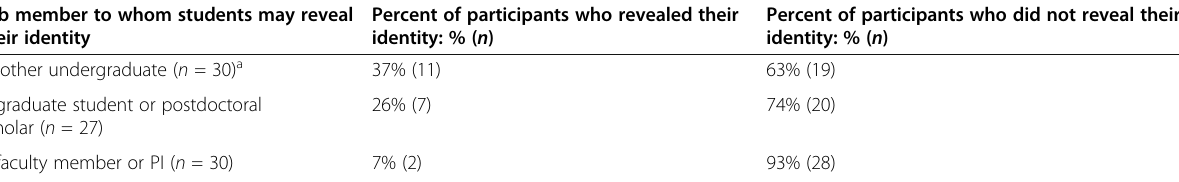
Table 2 Percent of undergraduate researchers who revealed their depression to a lab member whom they worked with regularly Lab member to whom students may reveal their identity